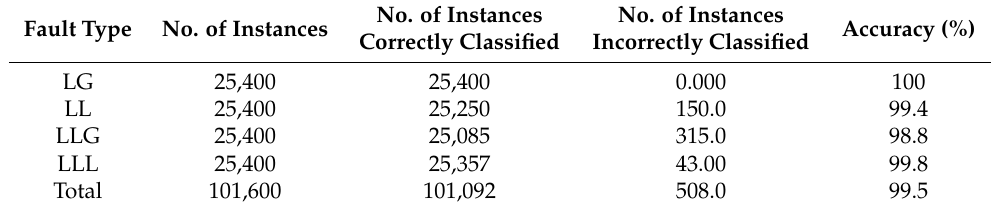
Table 9. Fault classification accuracy on different phases.